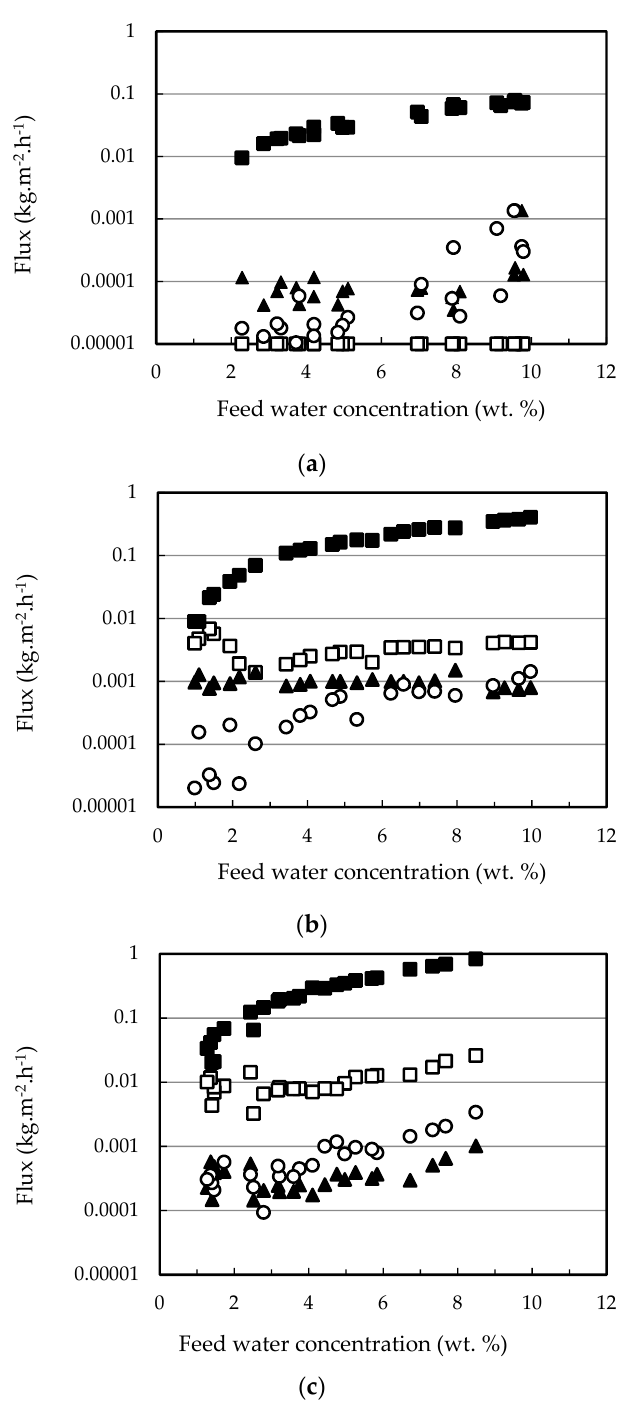
Figure 2. Individual component fluxes as a function of feed water content for the three PV membranes tested: ( a ) PERVAP™ 2116, ( b ) PERVAP™ 1131, ( c ) PERVAP™ 3100. ( (cid:4) ) Water, ( (cid:3) ) ethanol, ( (cid:115) ) ethyl lactate, ( ) lactic acid. Initial feed content: 13.5% lactic acid, 17.7% ethyl lactate, 10% water and 58.8% ethanol. Temperature = 60 °C. (cid:35)